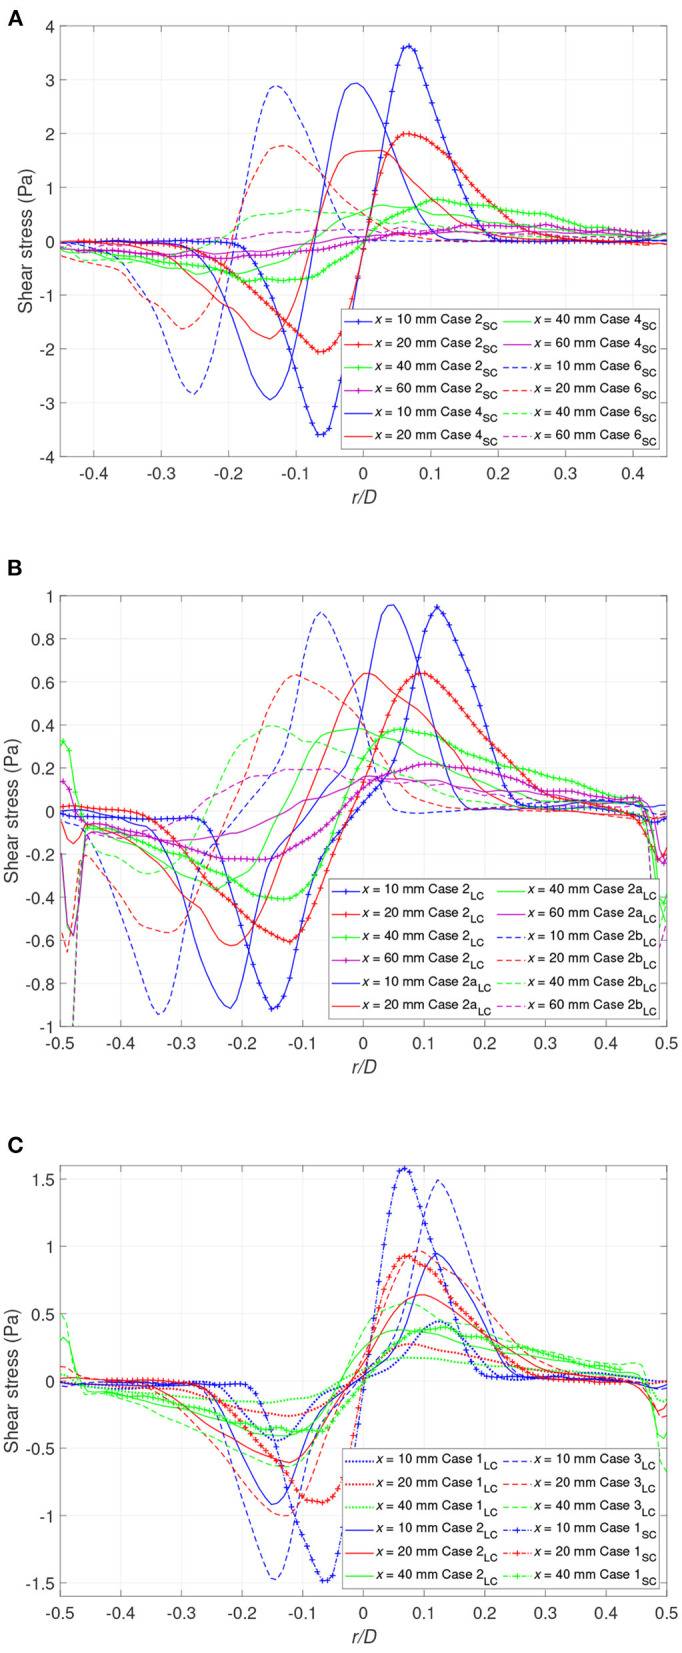
The shear stress profiles at different downstream locations for (A) the small cannula and Q = 0.5 (Case 2SC, Case 4SC, Case 6SC) (B) the large cannula and Q = 0.5 (Case 2LC, Case 2aLC, Case 2bLC), and (C) the large cannula and rc = 0 (Case 1LC, Case 2LC, Case 3LC, Case 4LC), and the small cannula (Case 1SC).